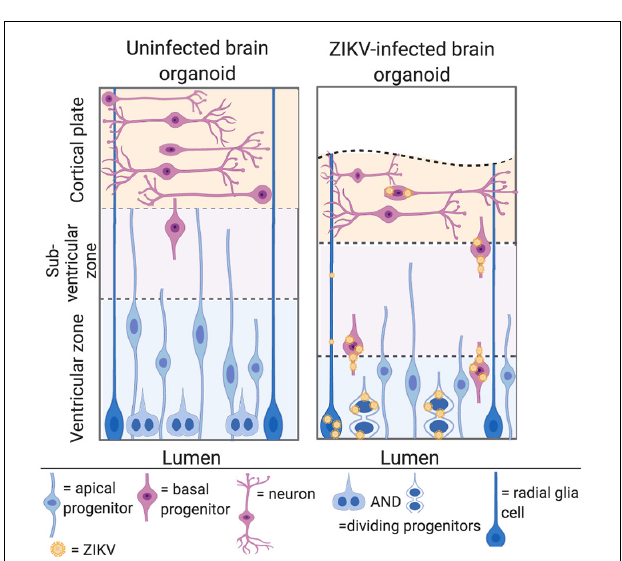
FIGURE 4 | ZIKV can infect NPCs in the developing cerebral cortex. Left panel: cerebral organoids are organised into a ventricular zone, subventricular zone, and cortical plate. Apical NPCs are shown in blue and reside at the apical/luminal side of the organoid, where the ventricular zone is located. Basal progenitors are shown in pink, and divide at the subventricular zone, further from the apical surface. Neurones are shown in pink at the cortical plate at the basal side of the organoid. Right panel: ZIKV infected cerebral organoid. ZIKV virions are shown in yellow. The cortical plate is reduced in volume, owing to apoptosis and premature differentiation of NPCs. Asian ZIKV localises to the apical NPCs at the ventricular zone, whilst African ZIKV infects both the apical NPCs and neurons at the cortical plate (adapted from Gabriel et al., 2017, created with